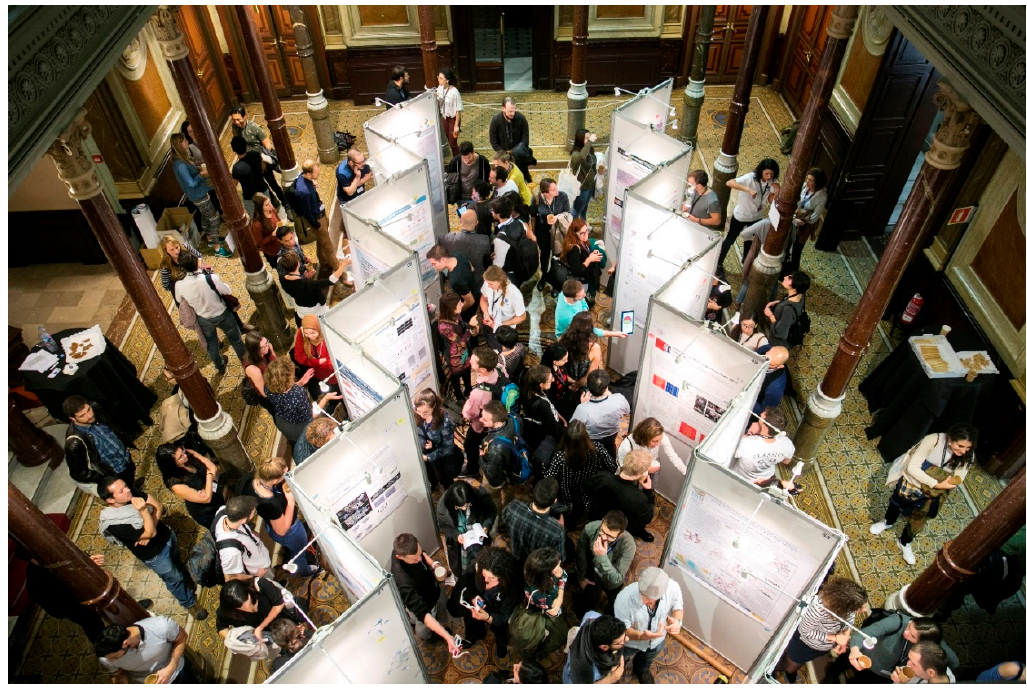
Figure 1. Attendees at ENABLE 2017.